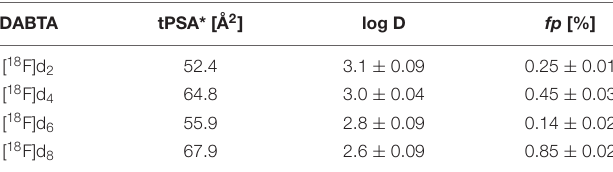
TABLE 2 | Some physicochemical properties of the DABTAs.